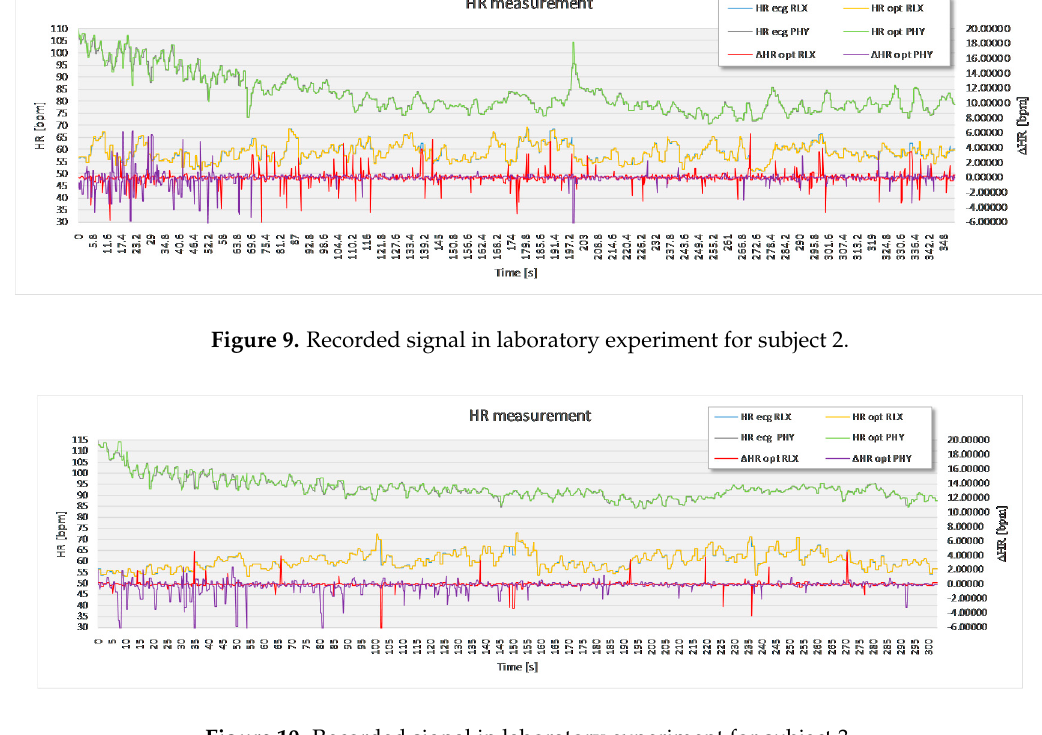
Figure 10. Recorded signal in laboratory experiment for subject 3.